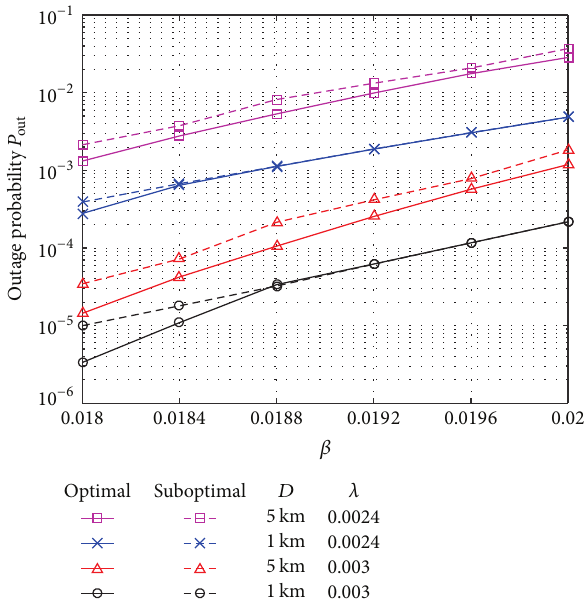
Figure 8: 𝑃 out versus 𝛽 , when 𝑏 𝑘 = 4 , 𝜆 = { 0.0024, 0.003 } , and 𝐷 = {1 km , 2 km }